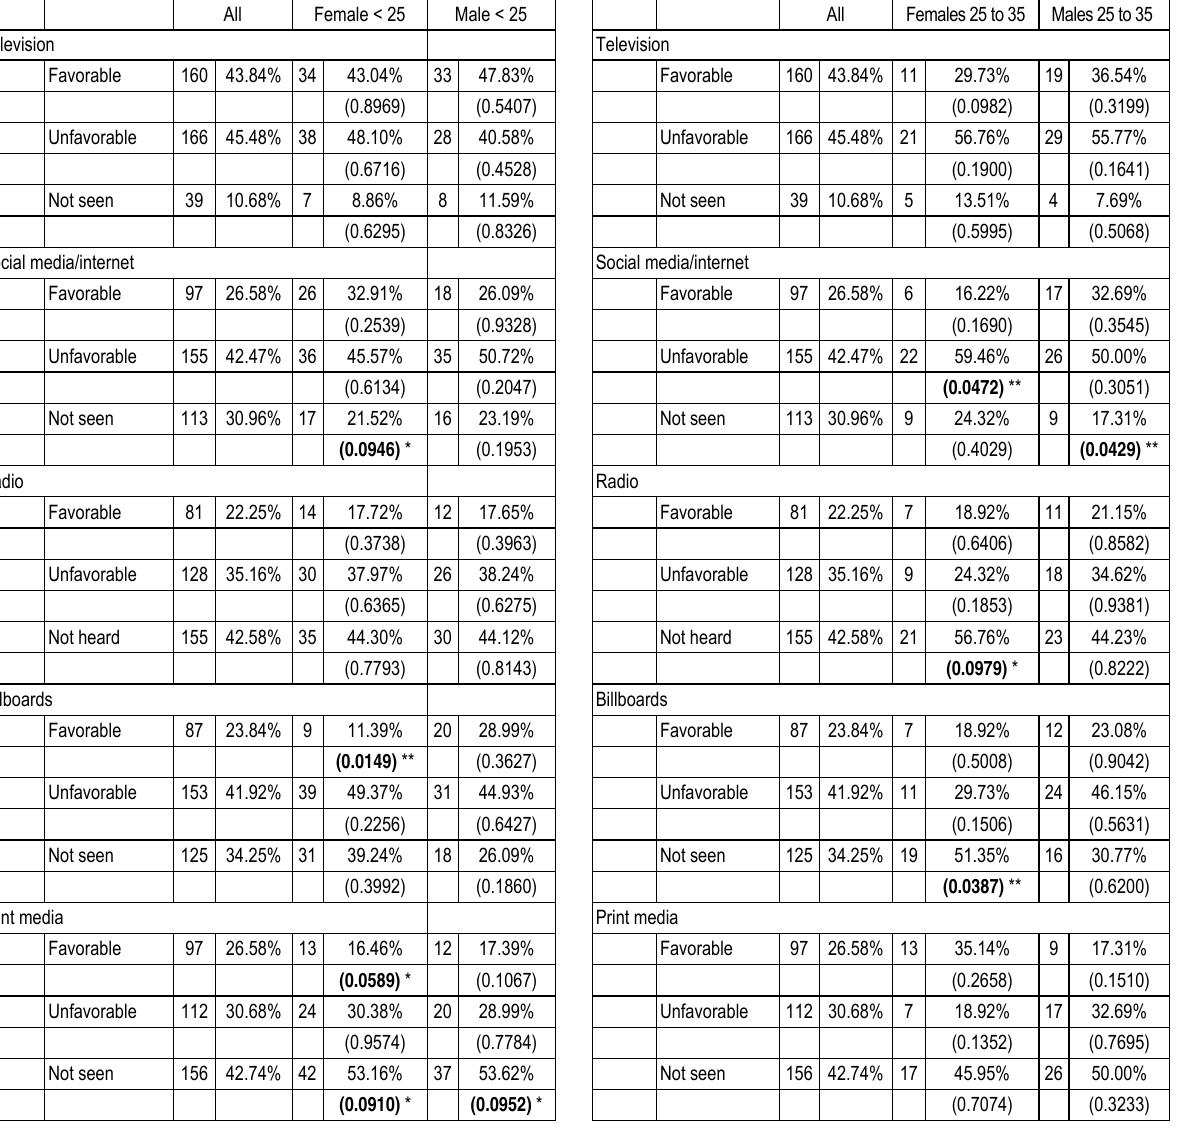
Table 3. Compare male and female by age This table shows the overall results and the results by gender for specific age groups that had significant differences. The table shows the total number of respondents for each category per question and the percent. The number in the parenthesis is the probability that the percentage responses are statistically significantly different from the overall survey responses based on a Chi-square statistic. One aste- risk indicates significance at the 10% level, two asterisks at the 5% level and 3 asterisks within the 1% level.